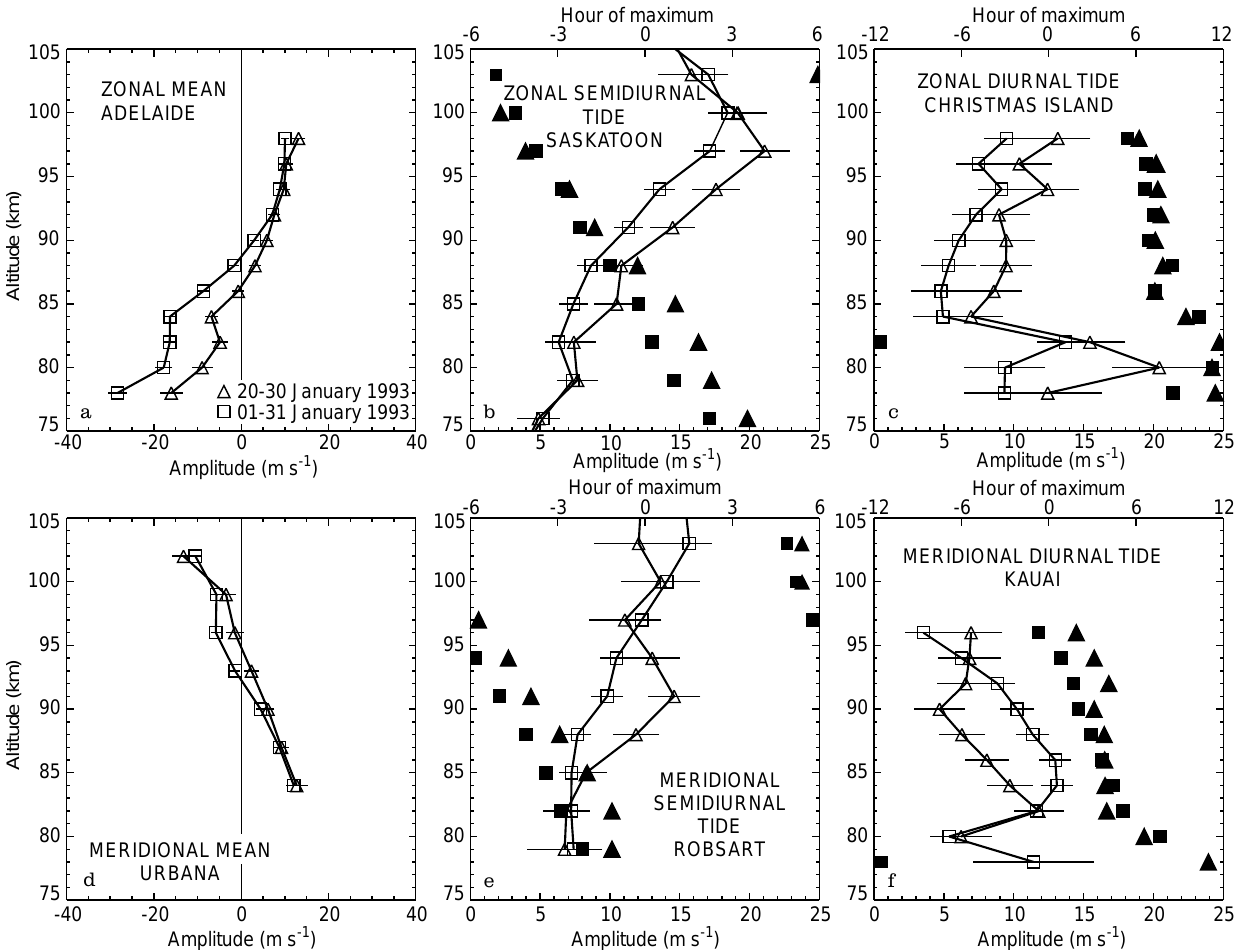
semidiurnal tide, and f Kauai meridional diurnal tide. Open symbols represent mean or tidal amplitude (m s (cid:255) 1 ; bottom scale) while the phases for the harmonic components are indicated by filled symbols (hour of maximum in solar local time; top